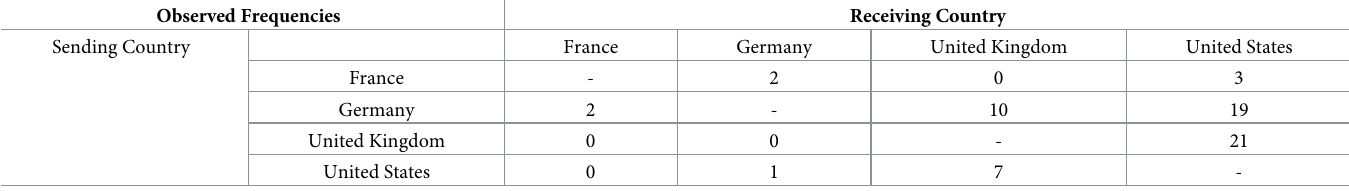
Table 1. Cross-country mobility of Nobel laureates. Observed Frequencies Receiving Country Sending Country